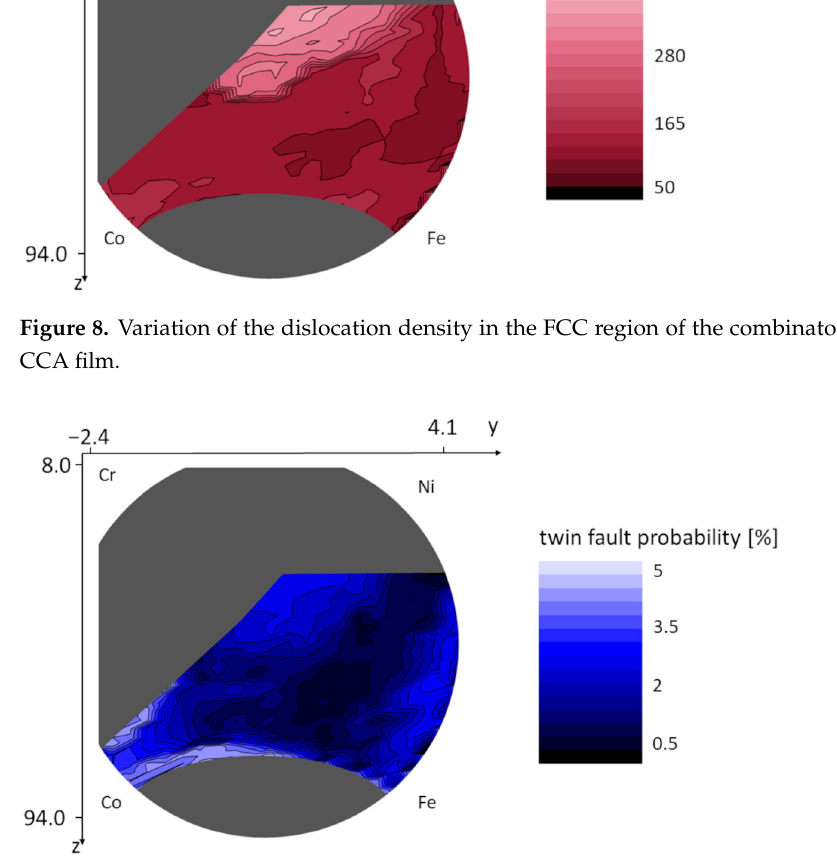
Figure 9. Variation of the twin fault probability in the FCC region of the combinatorial Co-Cr-Fe-Ni CCA film.